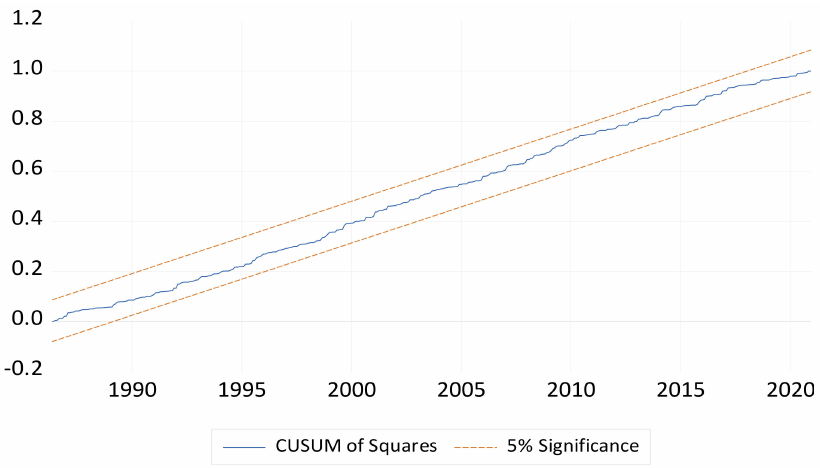
Figure 7. CUSUM-Square